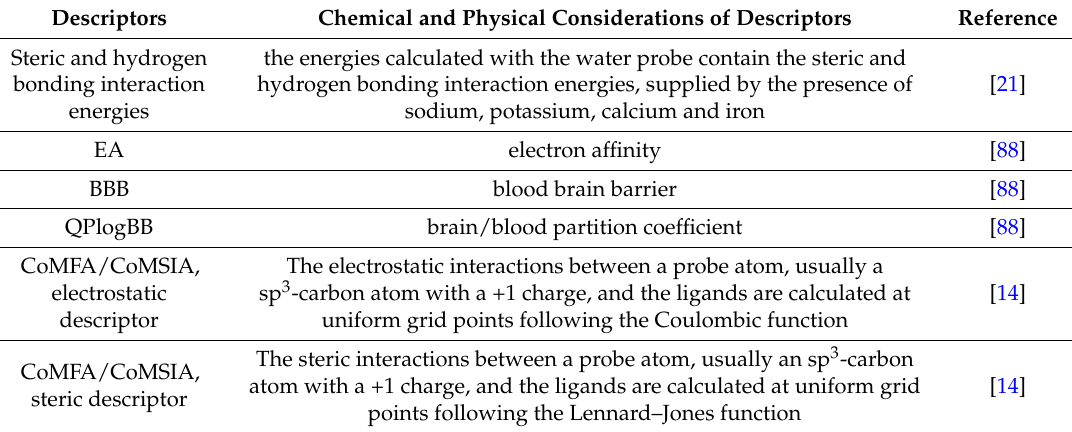
Table 2. Significant descriptors and chemical and physical considerations of them when antidepressants activity is